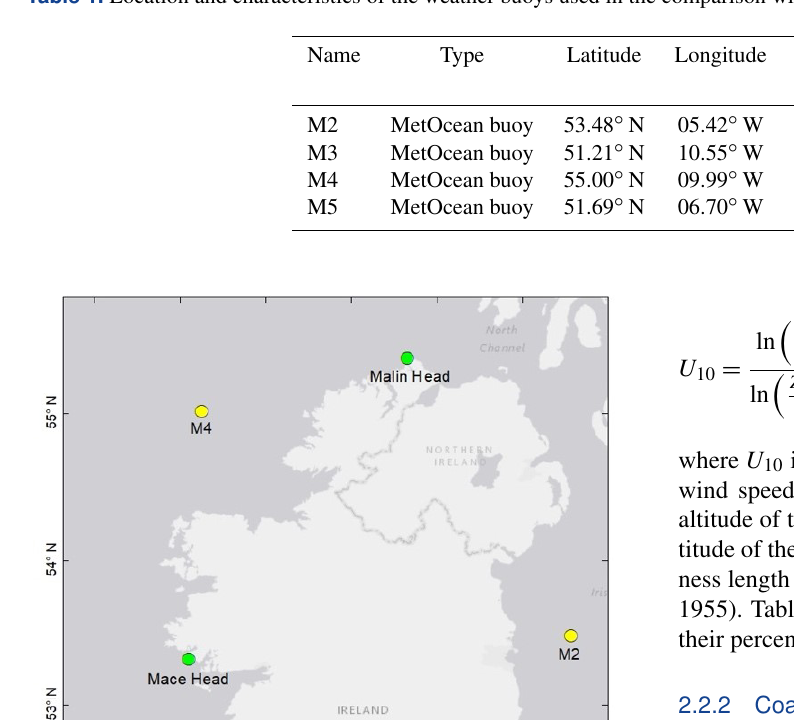
Table 1. Location and characteristics of the weather buoys used in the comparison with Sentinel-1 SAR Level 2 OCN product.